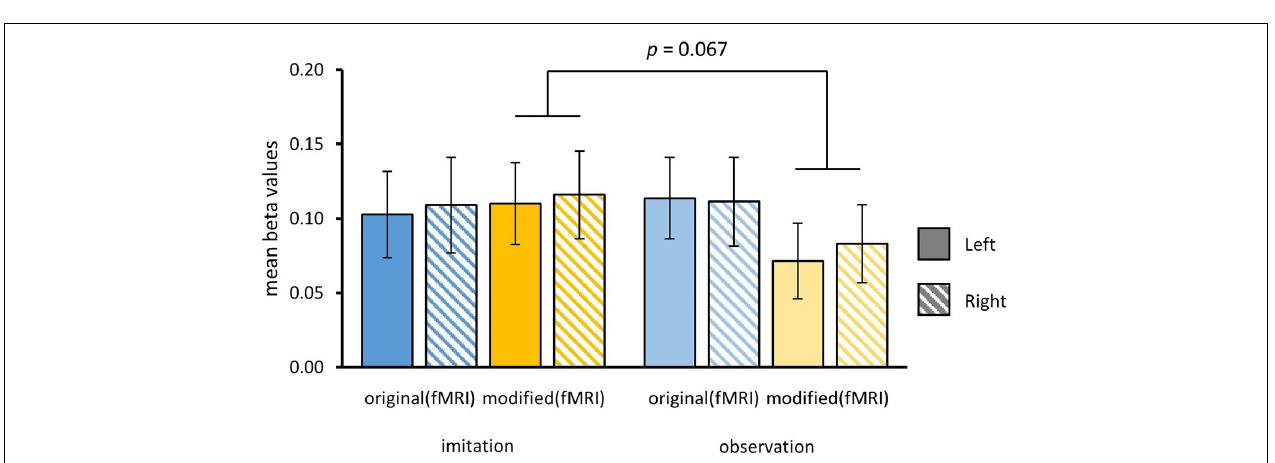
FIGURE 7 | Beta values for ROI of left and right hippocampal complex (HC). Beta values were separately extracted for original and modified videos for actions that have been formerly imitated or only observed. Contrasts were computed for each condition vs. implicit baseline. Bars show means and standard errors of means. Beta values were significantly higher in left hippocampus for imitated than only observed actions during presentation of modified videos.